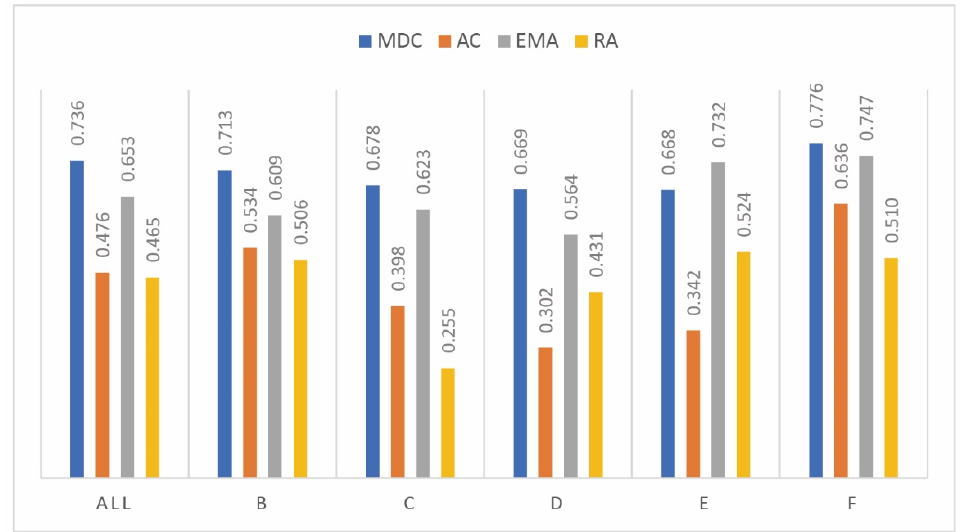
Figure 5. Structural model results of clustering. Results obtained in this study by using SmartPLS software. Table 5. Hypothesis results of clustering.